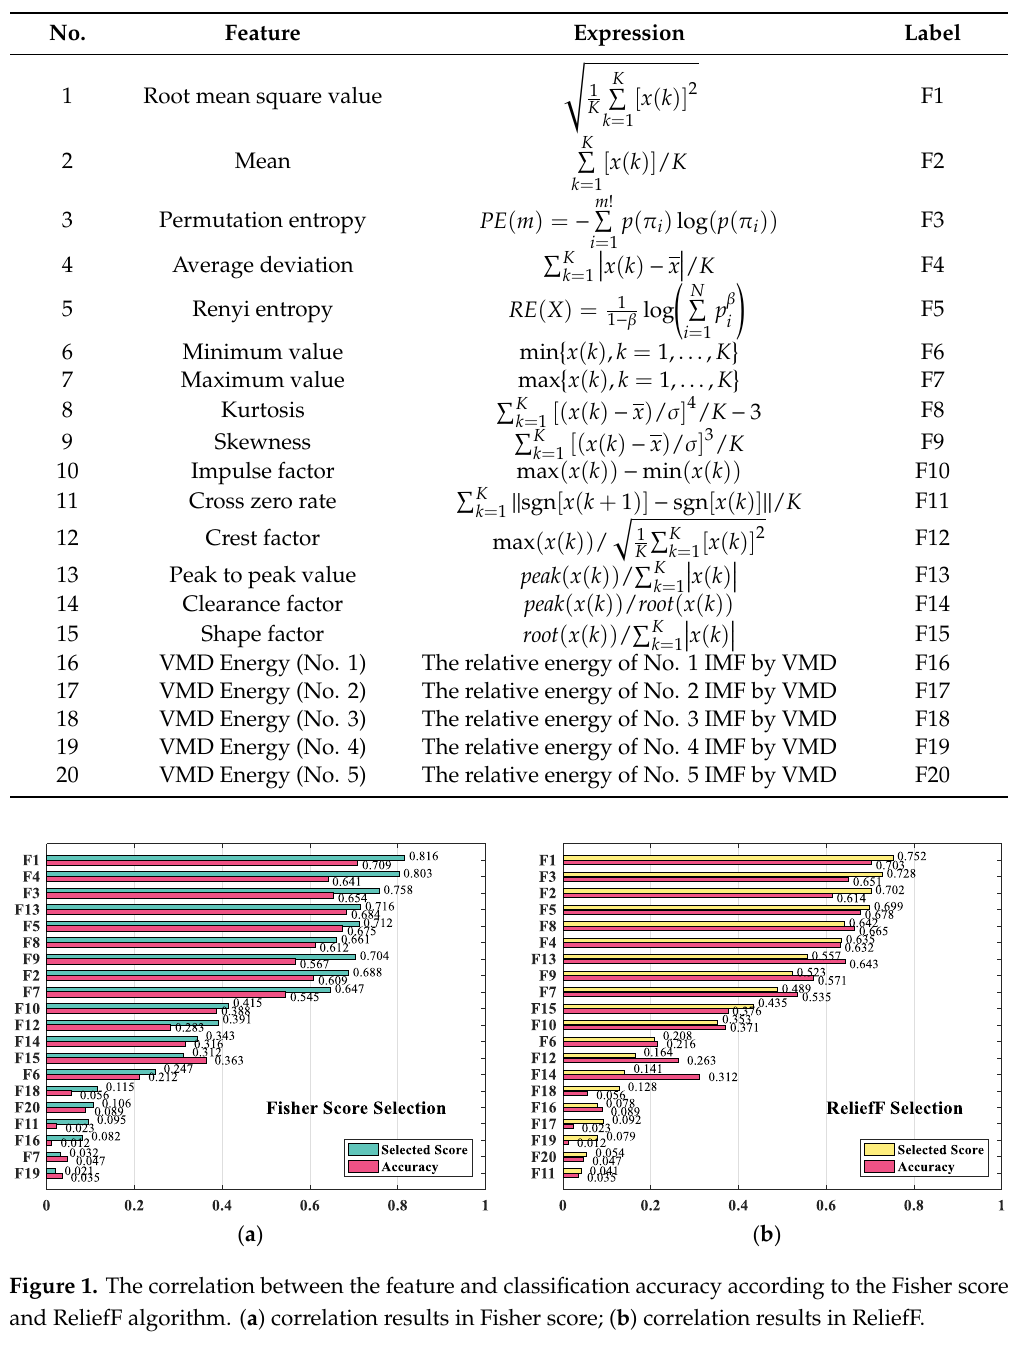
Table 2. The original feature generation.